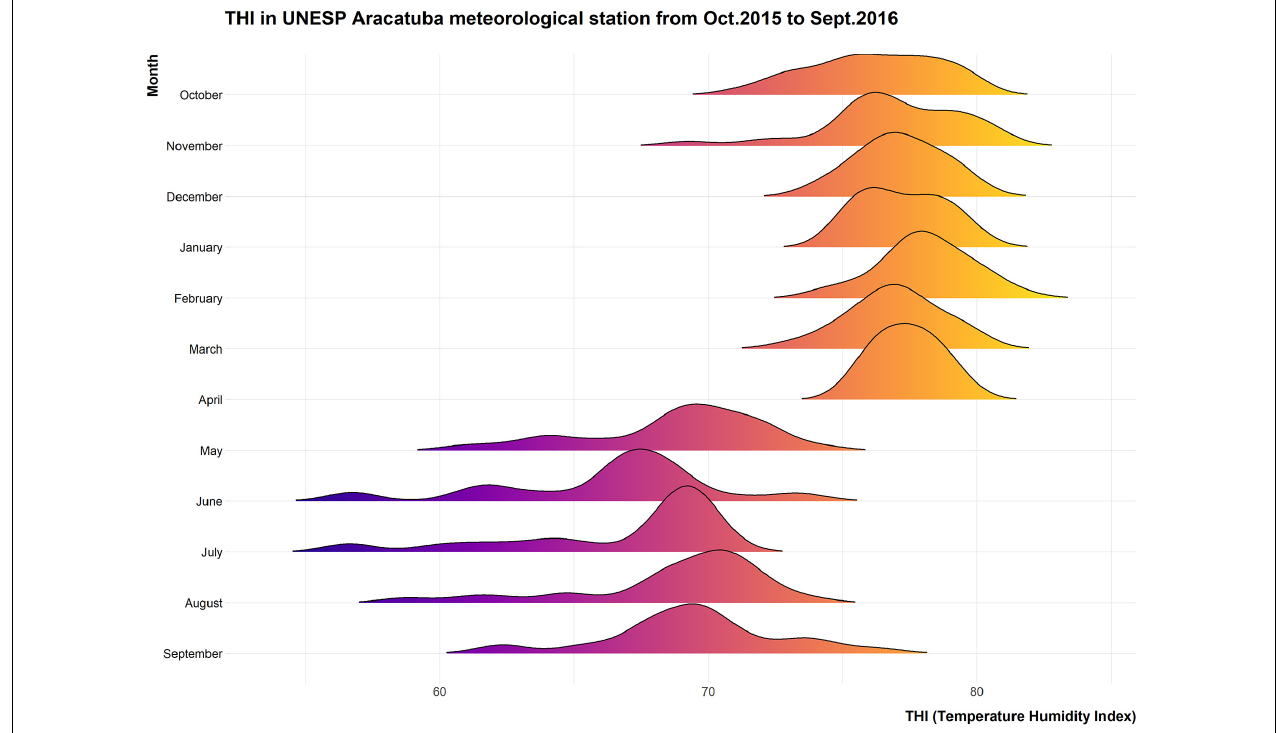
FIGURE 2 | Ridgeline plot showing distribution of daily average THI recorded at CETESB meteorological station located in the UNESP campus from October 2015 to September 2016.